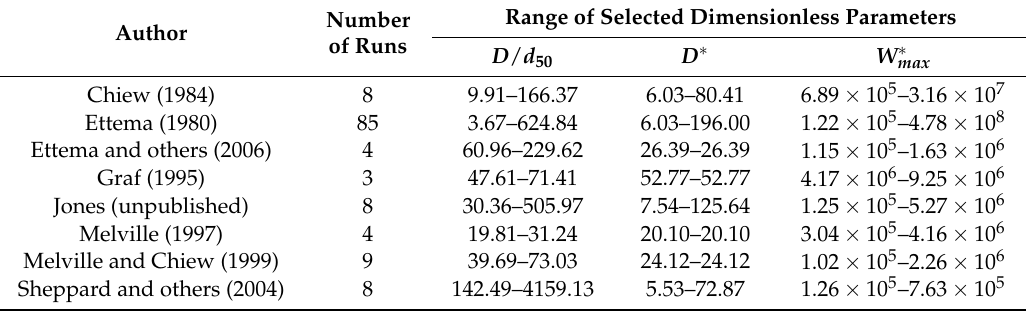
Table 4. Summary of the filtered experimental data. Data source: Sheppard et al.